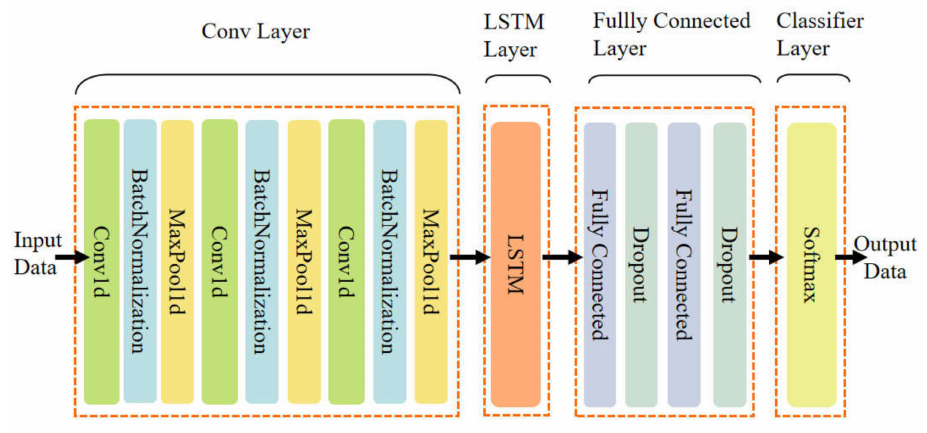
Figure 4. CNN-LSTM network architecture